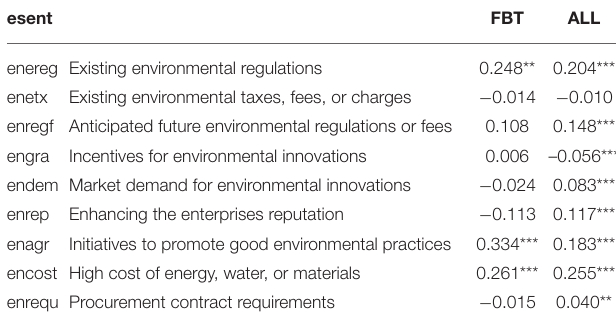
TABLE 6 | Multivariate regression parameters to determine the factors that contribute to the circular benefits of organizational innovations. ecorg FBT ALL